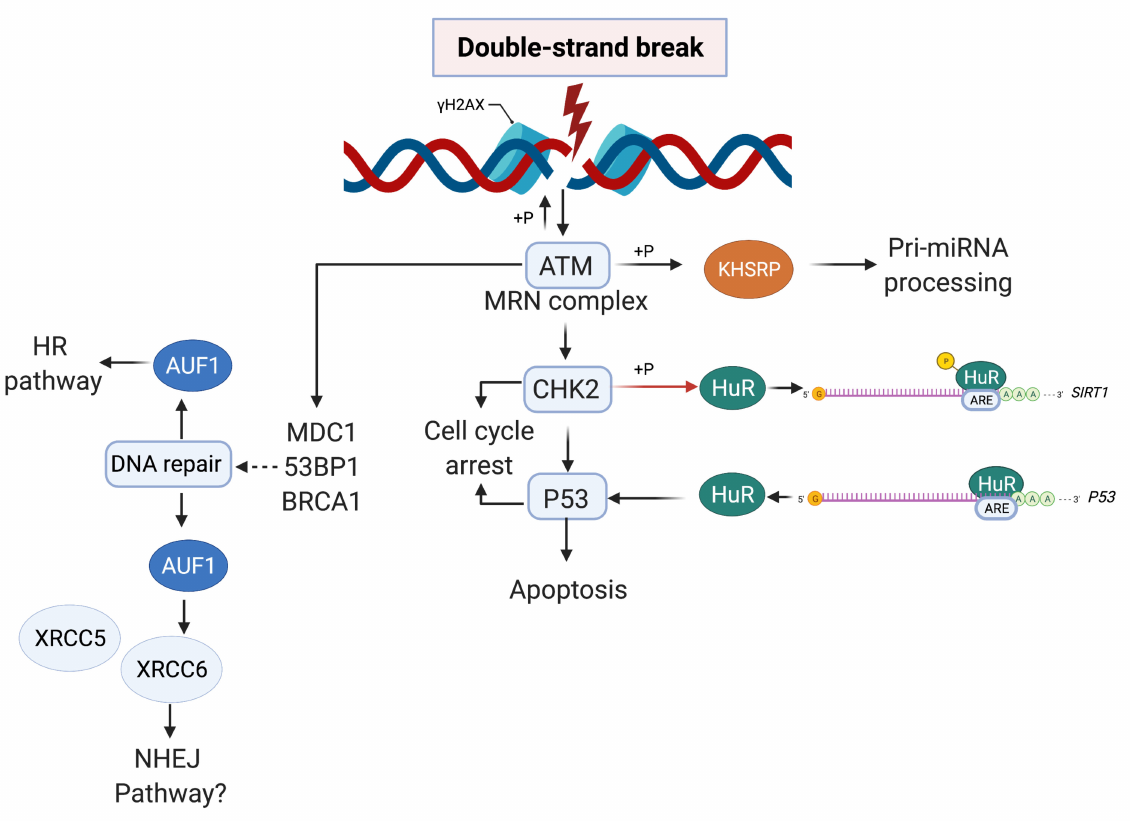
Figure 1. AU-RBPs at the nexus of the double strand break repair. DSBs initiated by endogenous or exogenous sources (red bolt) primarily lead to the activation of ATM. Initially, exposed DNA ends are sensed by the Mre11-Rad50-Nbs1 (MRN) complex, a key regulator of ATM activation, resulting in phosphorylation (+P) and activation of ATM. Activated ATM, phosphorylates downstream effectors CHK2, p53, BRCA1, and 53BP1 mediating cell-cycle arrest, apoptosis, and DNA repair through homologous recombination (HR) or non-homologous end-joining (NHEJ) pathways. ATM-directed phosphorylation of histone 2AX at serine 139 ( γ H2AX) is recognised by MDC1, resulting in wide- spread activation of γ H2AX over chromatin domains recruiting DNA repair factors at the site of DNA damage. AU-RBPs have been reported to form direct interactions, such as, KHSRPs phosphorylation by ATM early in the DSB pathway promoting KHSRP’s role in pri-miRNA processing. AU-RBP HuR is phosphorylated by CHK2 promoting destabilsation of target mRNA sirt1 . Alternatively, HuR may also stabilise p53 mRNA, promoting p53 translation to coordinate the DDR. AU-RBP AUF1 has been shown to associate with DSB repair through HR and may also interact with proteins involved in NHEJ, such as XRCC5 and XRCC6 (discussed